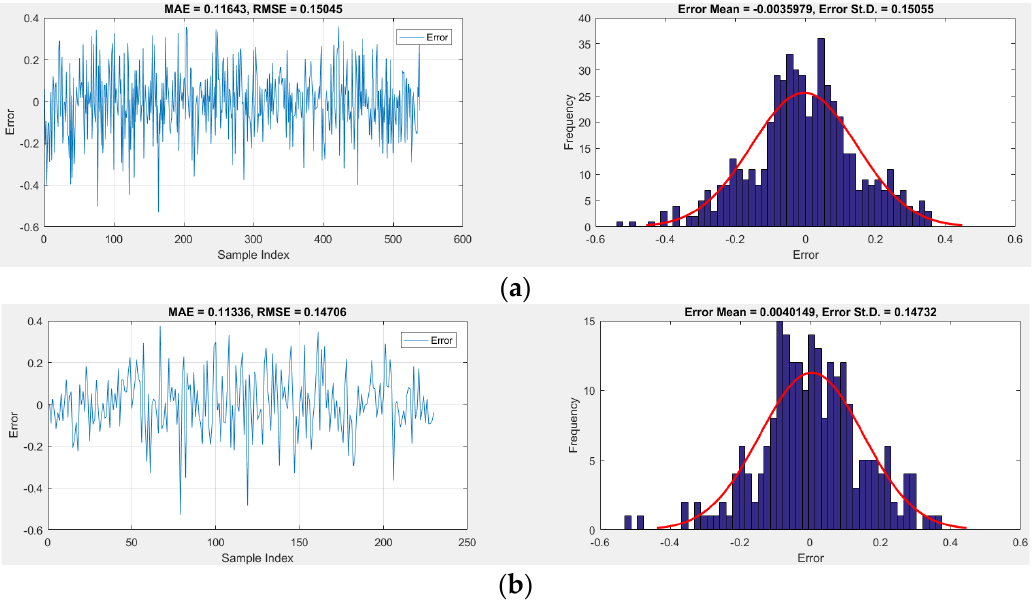
Figure 6. Frequency and minimum value of errors in HHO − ANFIS − 100 best fit structure. ( a ) Train- ing dataset. ( b ) Testing dataset.